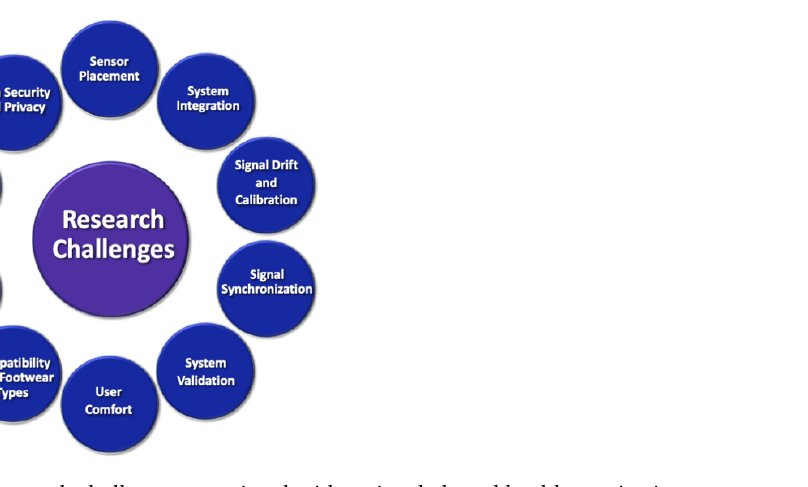
Figure 8. Research challenges associated with an insole-based health monitoring